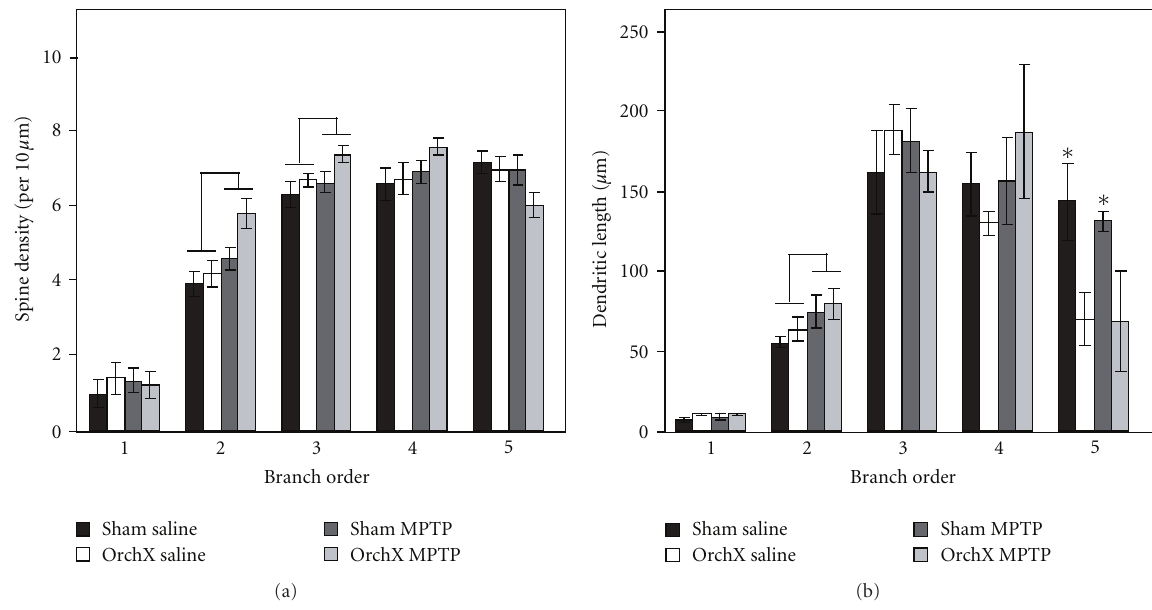
Figure 4: Branch order totals. Spine density (a) and dendritic length (b) for first- to fifth-order branches in striatal medium spiny neurons ( n = 5 mice/group). Saline-injected mice include gonad-intact (black bars) and orchidectomized (white bars) males. MPTP-treated mice include gonad-intact (dark gray bars) and orchidectomized (light gray bars) males. Bars represent an e ff ect of MPTP ( P < . 05), and asterisks represent an e ff ect of gonadectomy ( P < . 05). Abbreviations: OrchX, orchidectomized; Sham,